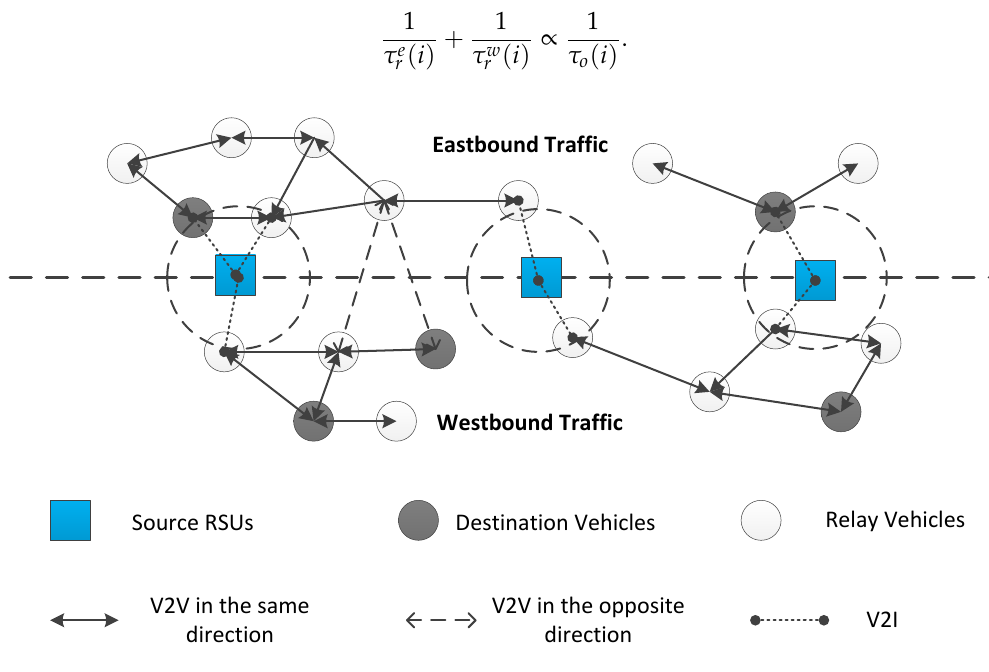
Figure 3. RSU allocation in a constructed